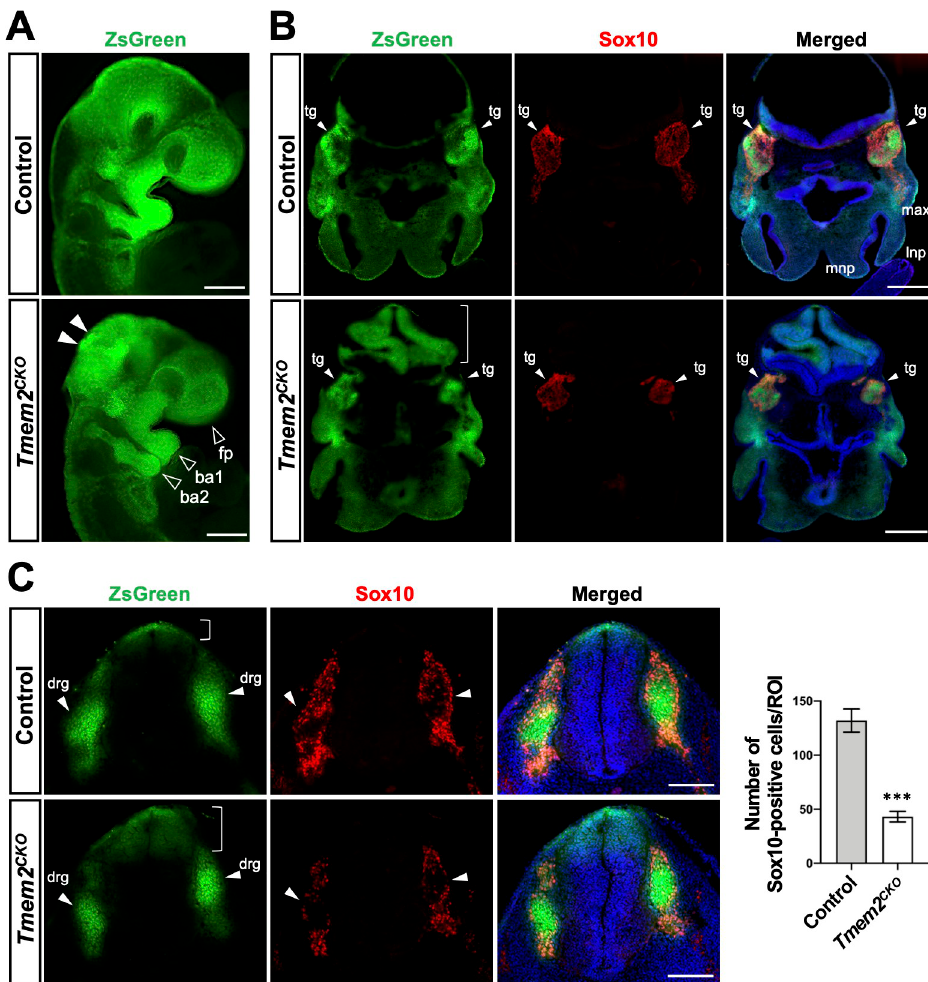
Fig 4. Lineage tracing of NCCs. ( A ) Whole-mount fluorescence images of Tmem2 CKO ;ZsGreen and control embryos at E9.5. In Wnt1 - Tmem2 CKO ;ZsGreen embryos, domains occupied by ZsGreen-labeled NCCs are smaller and the intensity of ZsGreen signals is reduced in the facial prominence and in the first and second branchial arches ( open arrowheads ). Aberrant accumulation of ZsGreen -positive cells is observed in the dorsal midbrain and hindbrain of Tmem2 CKO ;ZsGreen embryos ( filled arrowheads ). ( B ) Transverse sections of Tmem2 CKO ;ZsGreen and control embryos at E10.5 stained for Sox10. Arrowheads indicated trigeminal ganglia ( tg ). The number of Sox10-positive NCCs arrived at the trigeminal ganglia is significantly reduced in Tmem2 CKO ;ZsGreen embryos. Bracket indicates abnormal folding of the hindbrain neuroepithelium. ( C ) Transverse sections through the caudal neural tube of Tmem2 CKO ;ZsGreen and control embryos at E10.5 stained for Sox10. In Tmem2 CKO ;ZsGreen embryos, the number of NCCs migrated to the dorsal root ganglia ( arrowheads ) is decreased, while the number remaining in the neural tube is increased ( brackets ). Bar graph shows the quantification of Sox10-positive cells in the dorsal root ganglia at E10.5. Data represent mean ± SD ( n = 5). ��� p < 0.001 by unpaired Student’s t -test. Scale bars, 500 μ m in A - C . fp , facial prominence; ba1 , the first branchial arch; ba2 , the second branchial arch; lnp , lateral nasal process; max , maxillary process; mnp , medial nasal process; tg , trigeminal ganglion; drg , dorsal root